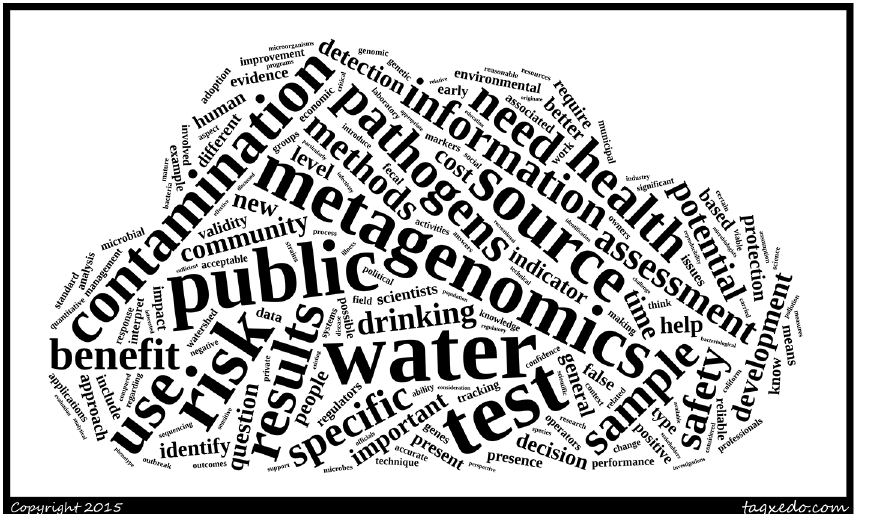
Fig 3. Word cloud generated from the Delphi round 1